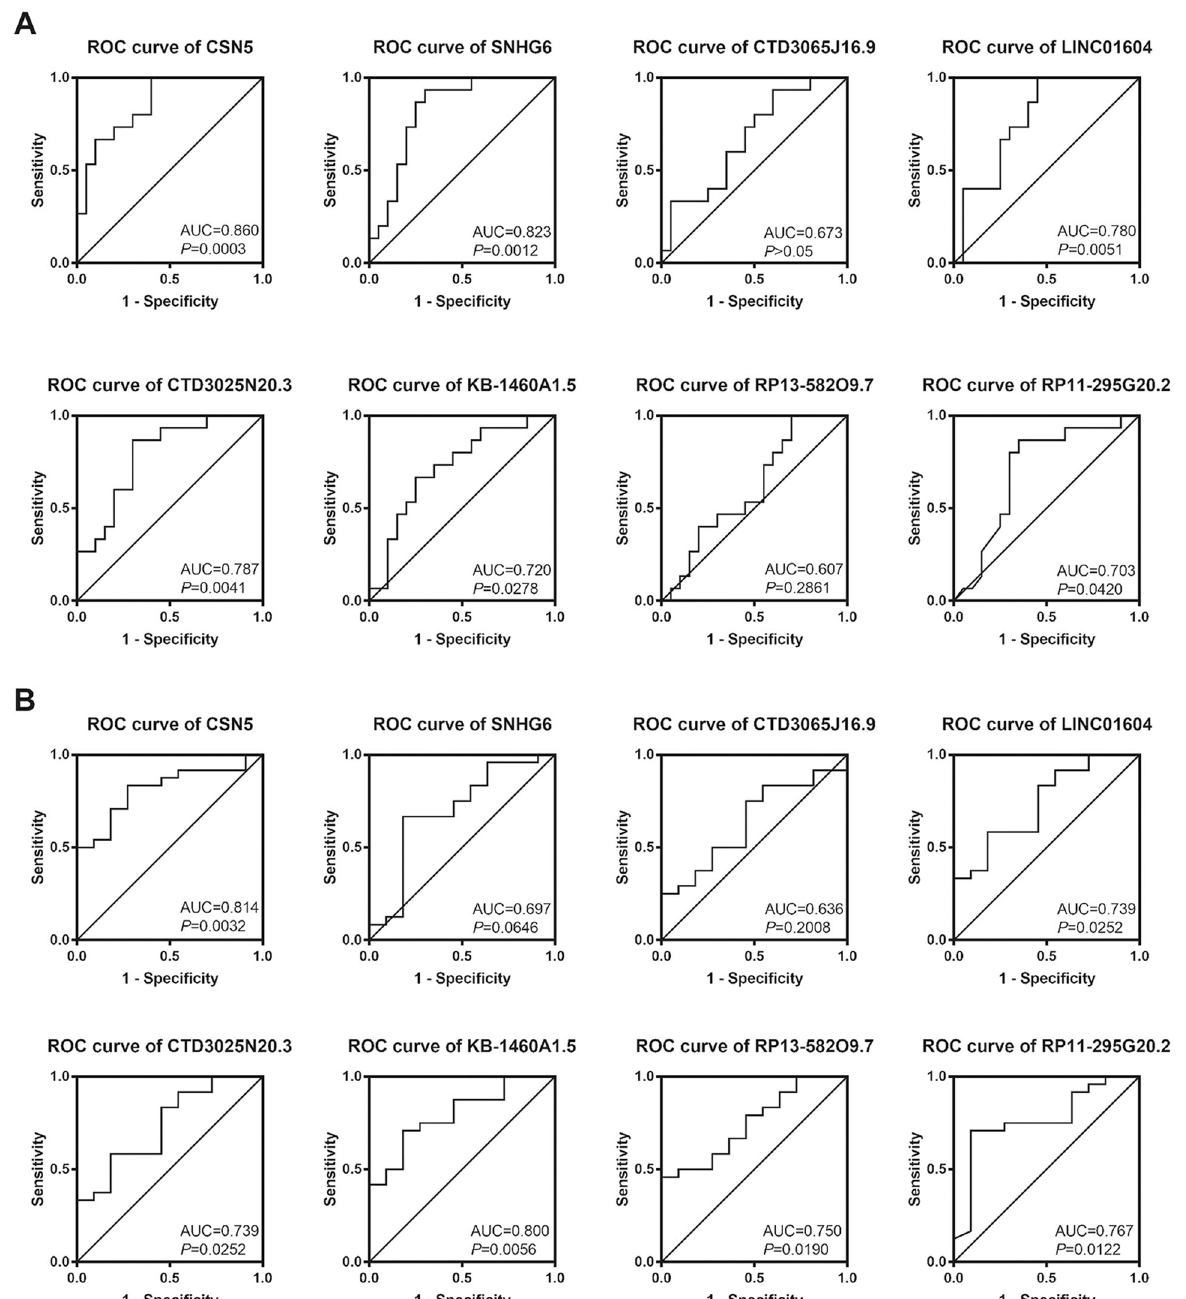
Fig. 5 ROC curves of CSN5 and seven lncRNAs expression. A The relative expression levels were proven to be a valuable parameter in the differentiation of HCC. B The predictive value of CSN5 and seven lncRNAs for the TNM stage of